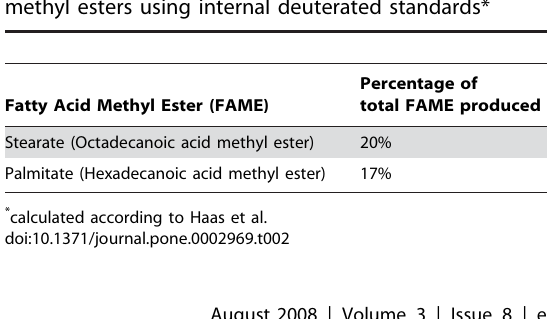
Table 2. Quantification of the two most abundant fatty acid methyl esters using internal deuterated